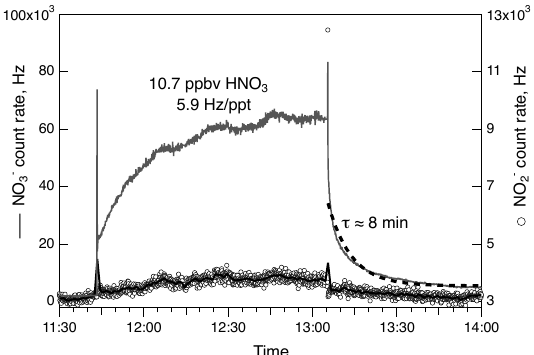
Fig. 5. Panel (a) shows the response of the NI-PT-CIMS to the HONO standard (gray line), introduced through the entire inlet. The simple exponential fit to the HONO signal when the standard was removed (dashed line) is also shown. Panel (b) shows the results of HONO calibrations under dry (squares) and 30% humidity (trian-